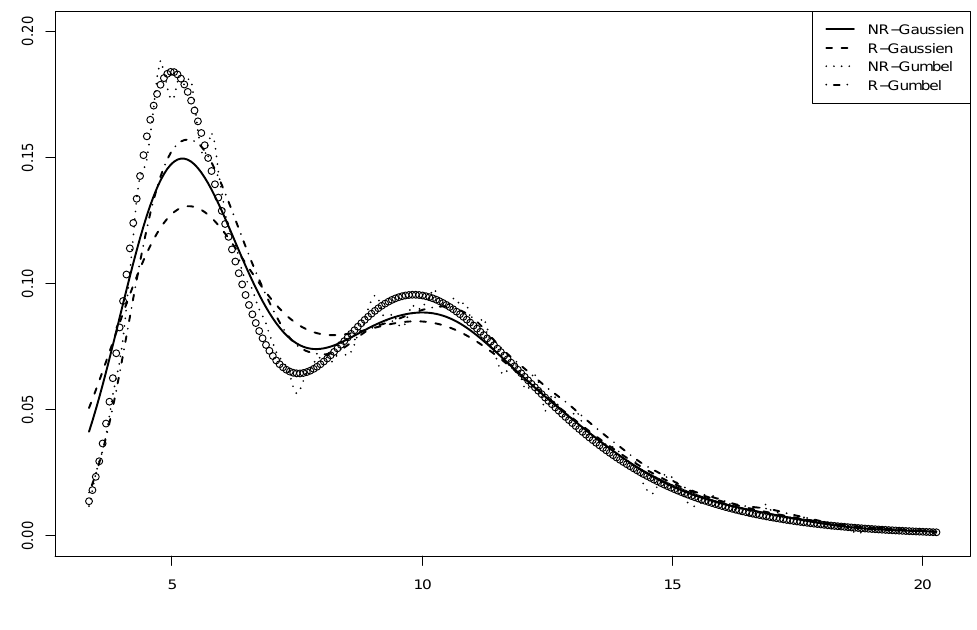
Figure 2: Qualitative comparison between the four considered estimators. The circles represent the true distribution. Here we consider the mixture of two Gumbel distributions 0.25 G um (5, 1) + 0.75 G um (10, 2) and the sample size n = 200